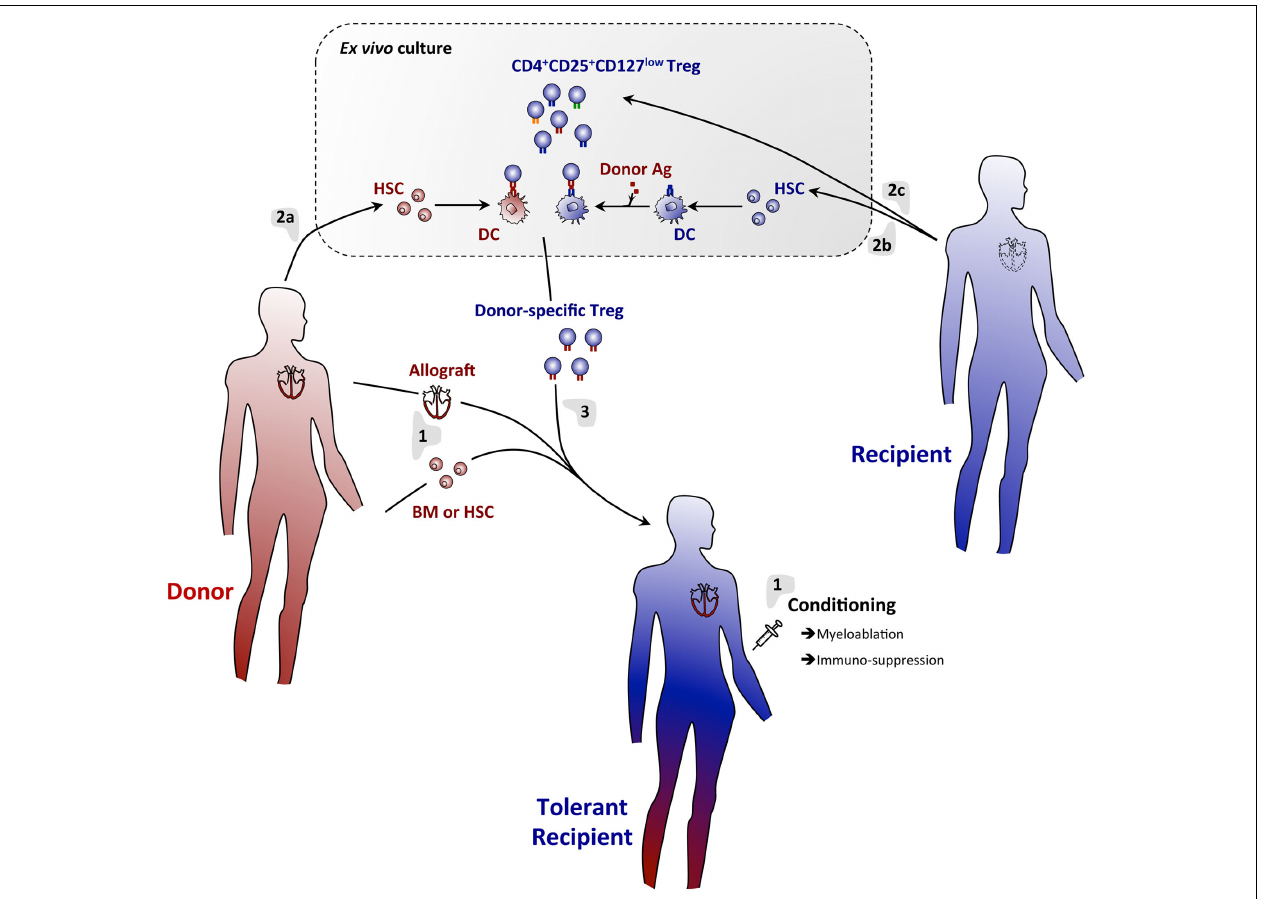
these antigens.Thus generated DC will then be co-cultured with host-derived Treg (c), allowing for expansion ofTreg specific for directly and